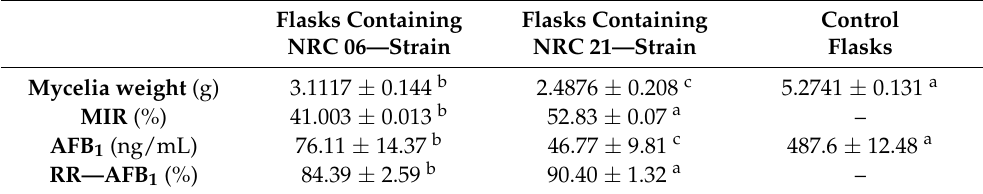
Table 6. Anti-aflatoxigenic effects of bacterial strains against the fungal growth of A. parasiticus and toxin production reduction in growth media.